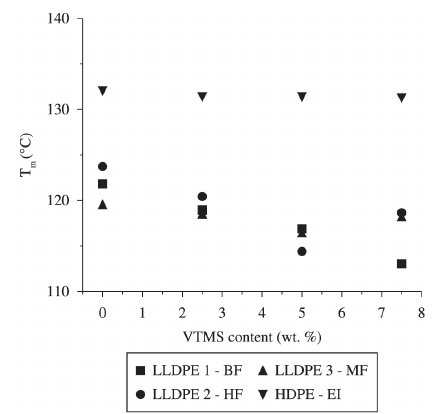
Figure 5. Melting temperature of crosslinked